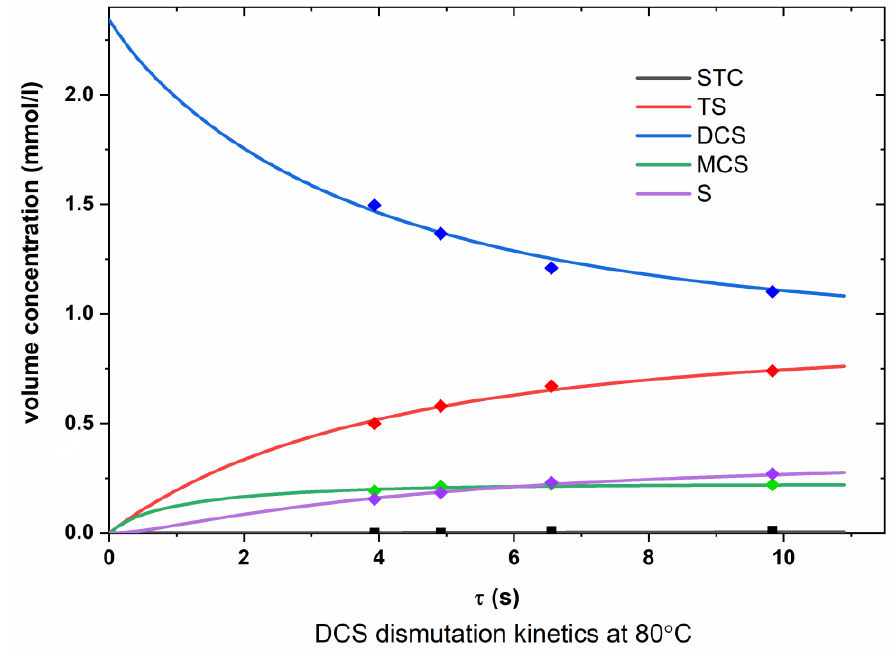
Figure A4. Dependence of the molar concentrations of chlorosilanes on time (DCS, 80 °C).